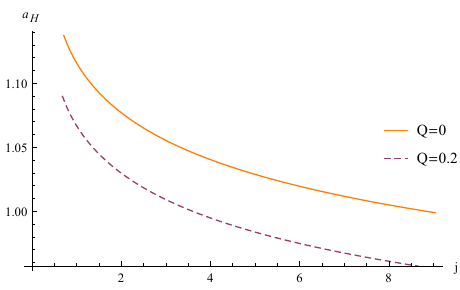
Figure 1 . The ( j; a H ) phase diagram of the large D charged black ring solution for n = 20( D = 24). The ring radius R runs from 1 : 1 to 20, so both the not-thin region and thin region ( R (cid:29) 1) are covered. The solid curve shows the behavior of the uncharged case Q = 0. The dashed line shows the behavior of the charged case with Q = 0 :